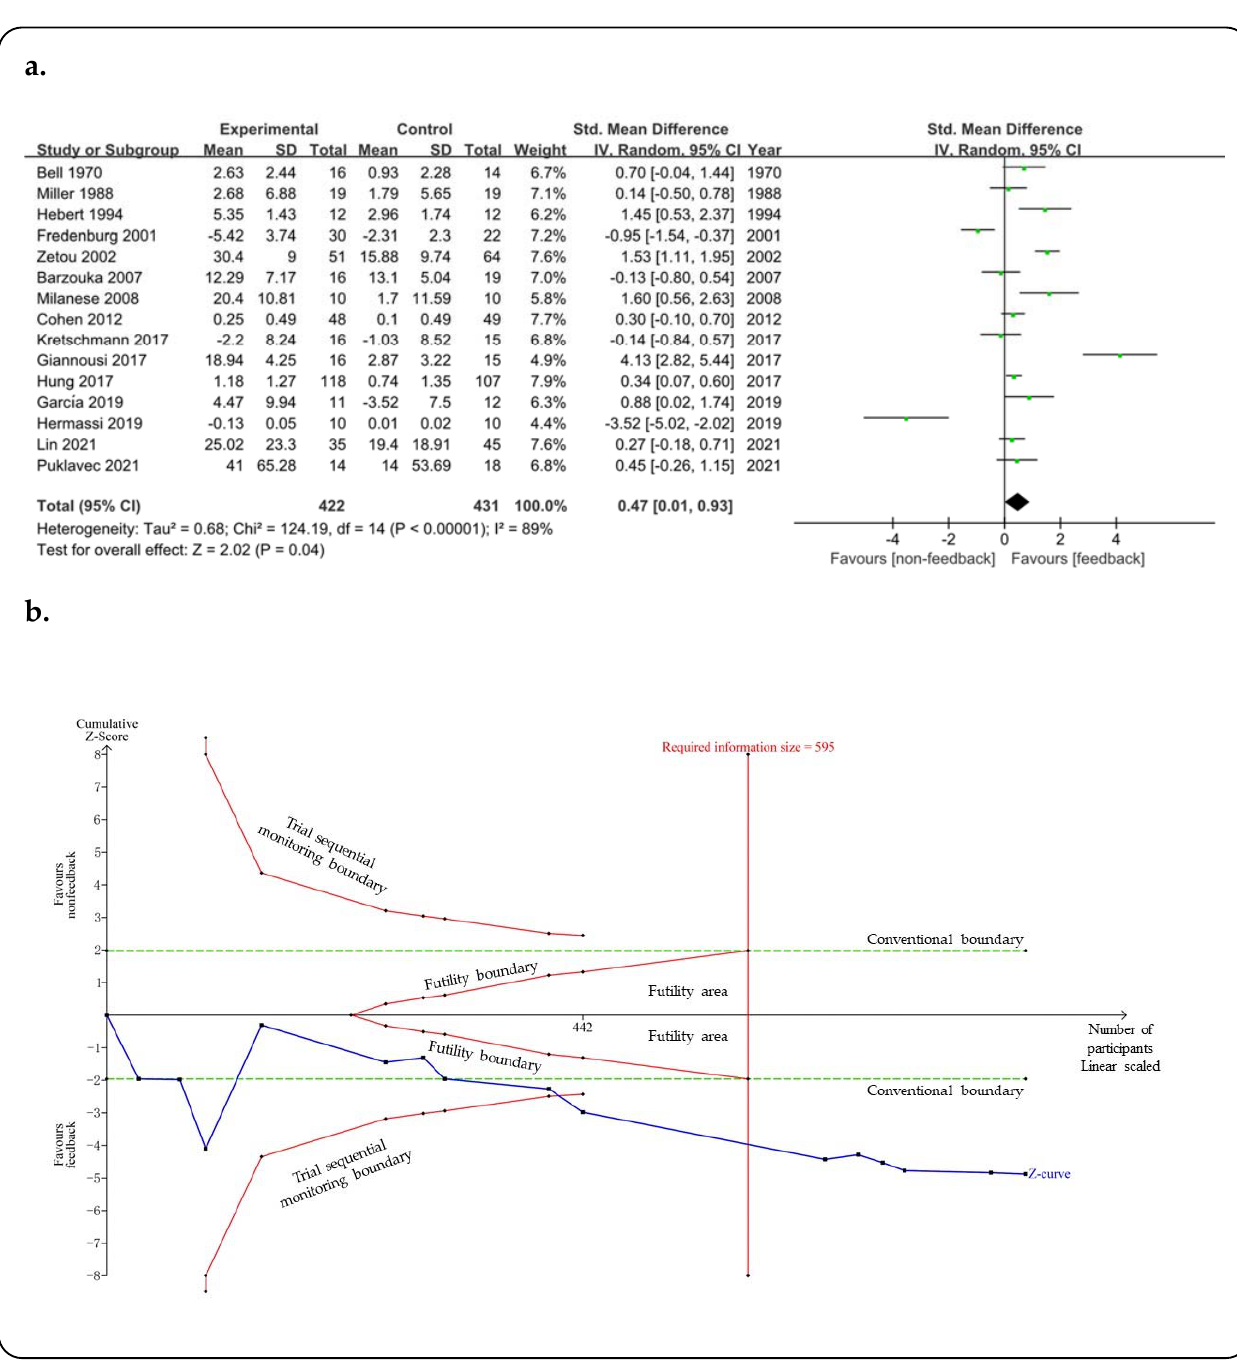
Figure 3. Effect of feedback on motor skill learning across all included studies. ( a ) Forest plot of feedback vs. non ‐ feedback on motor skill learning. Bell (1970) [35], Miller (1988) [36], Hebert (1994) [37], Fredenburg (2001) [38], Zetou (2002) [39], Barzouka (2007) [21], Milanese (2008) [40], Cohen (2012) [41], Kretschmann (2017) [44], Giannousi (2017) [42], Hung (2017) [43], García (2019) [17], Hermassi (2019) [18], Lin (2021) [19], Puklavec (2021) [20]. ( b ) Trial sequential analysis to assess the effect of feedback on motor skill learning with two ‐ sided monitoring boundary, α = 5%, β = 20%. Required information size was calculated based on TSA estimation, which was 595.